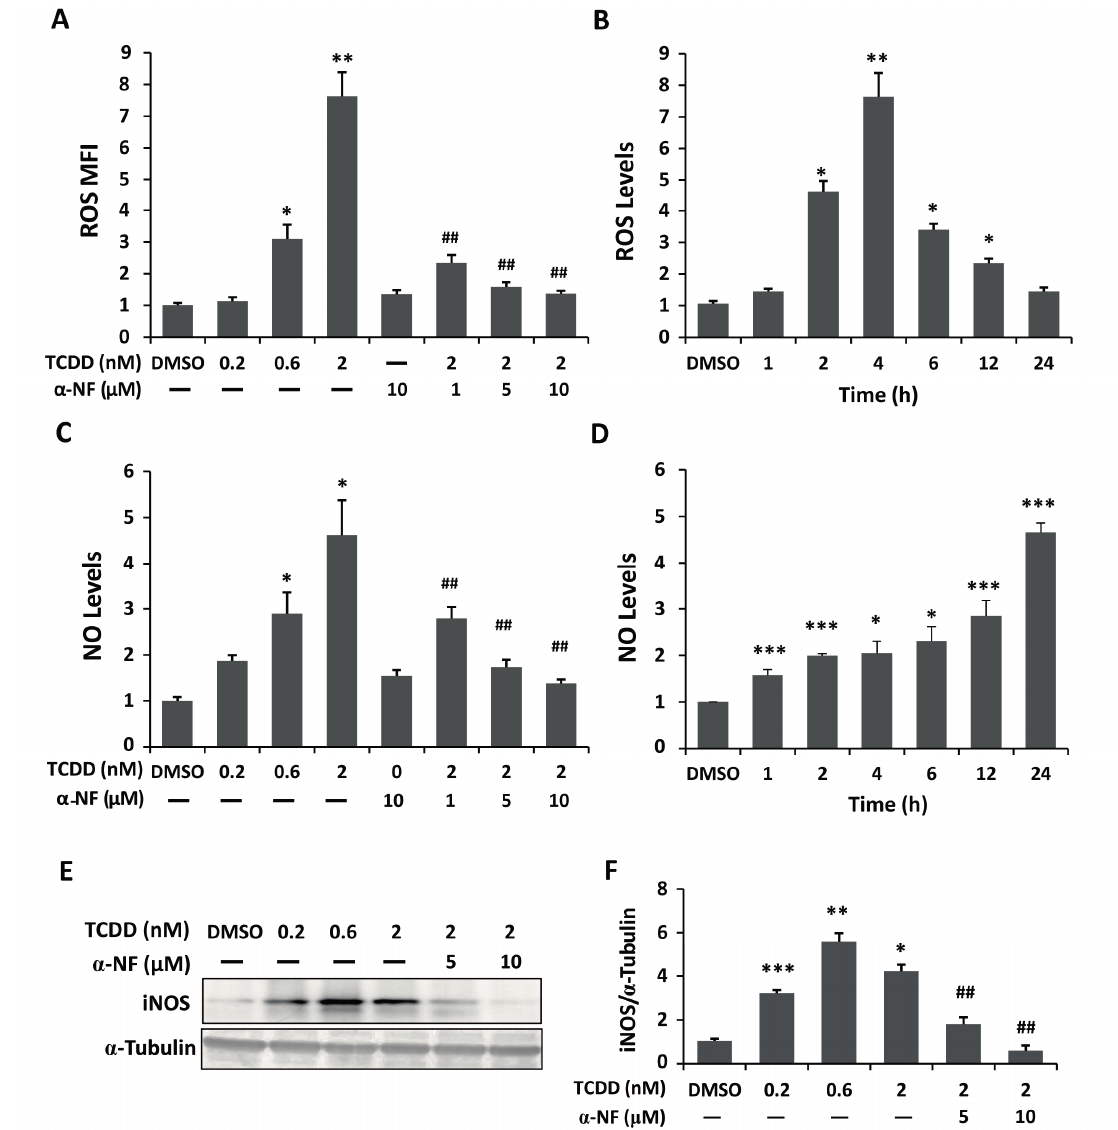
Figure 2. TCDD-mediated generation of reactive oxygen species (ROS) and nitric oxide (NO) in trophoblastic cells. ( A , C ) Cells were treated with the various doses of TCDD (0.2, 0.6, 2, 6, and 10 nM) with or without α -NF pretreatment (the AhR antagonist); ( B , D ) Cells were treated with 2 nM TCDD for different time periods; ( A , B ) ROS were measured through 5-(and-6)-chloromethyl-2',7'-dichlorodihydrofluorescein diacetate acetyl ester (H 2 DCFDA) staining followed by flow cytometry; ( C , D ) NO production was detected using the Griess Reagent, as described in Methods; ( E ) The expression level of inducible NOS (iNOS) protein in the TCDD-treated cells with or without α -NF pretreatment was detected by western blotting and quantified by densitometry; ( F ) Pretreatment with α -NF reduced TCDD-induced ROS generation, NO production, and iNOS expression. The plots are presented as the mean ± SD ( n = 3). * p < 0.05; ** p < 0.01; *** p < 0.001 compared with the control group. ## p < 0.01 compared with the 2 nM TCDD-treated